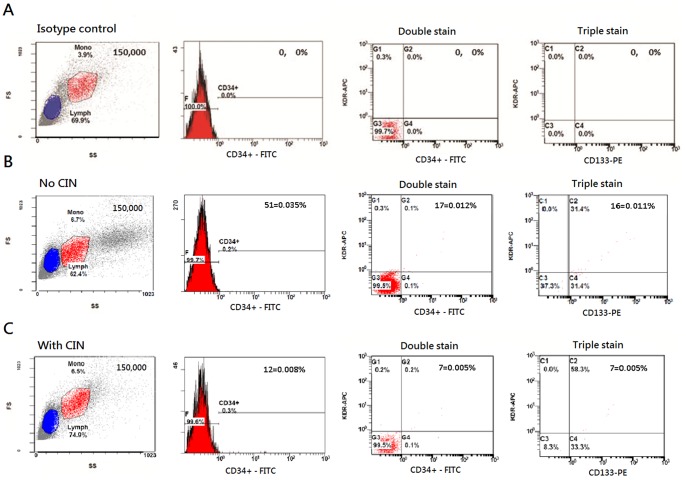
Representative flow cytometry analysis for quantifying the number of circulating endothelial progenitor cells in study subjects: (A) isotype control, (B) patients without CIN (C) patients with CIN.The numbers of circulating EPCs were gated with monocytes and defined as CD34+CD45low, CD34+KDR+CD45low, and CD34+KDR+CD133+CD45low. CIN, contrast-induced nephropathy.